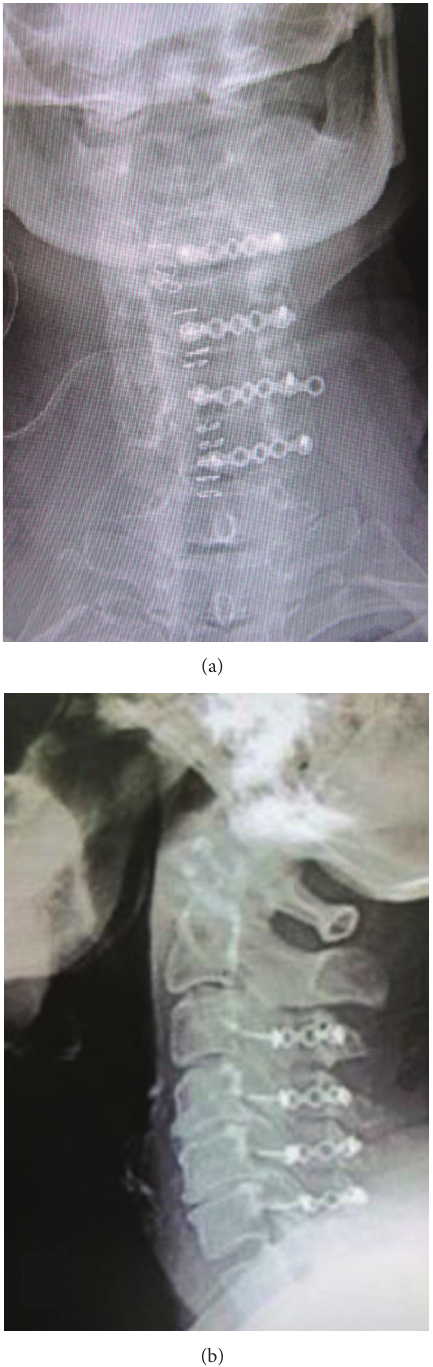
Figure 3: Postoperative AP and lateral film.